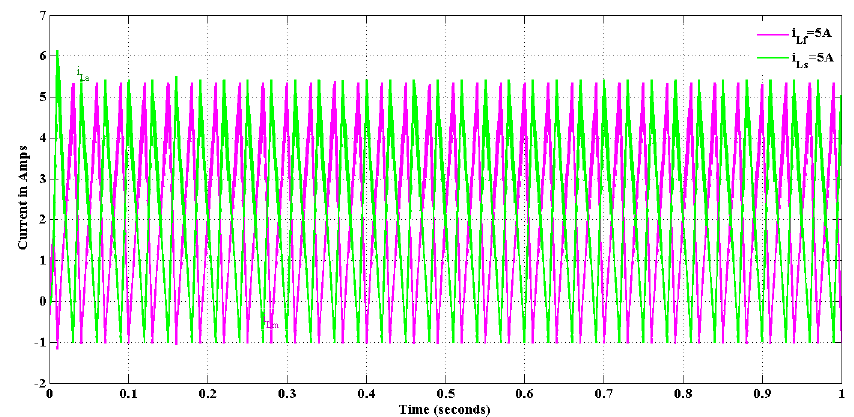
Figure 14. Inductor current wave form in powering mode.